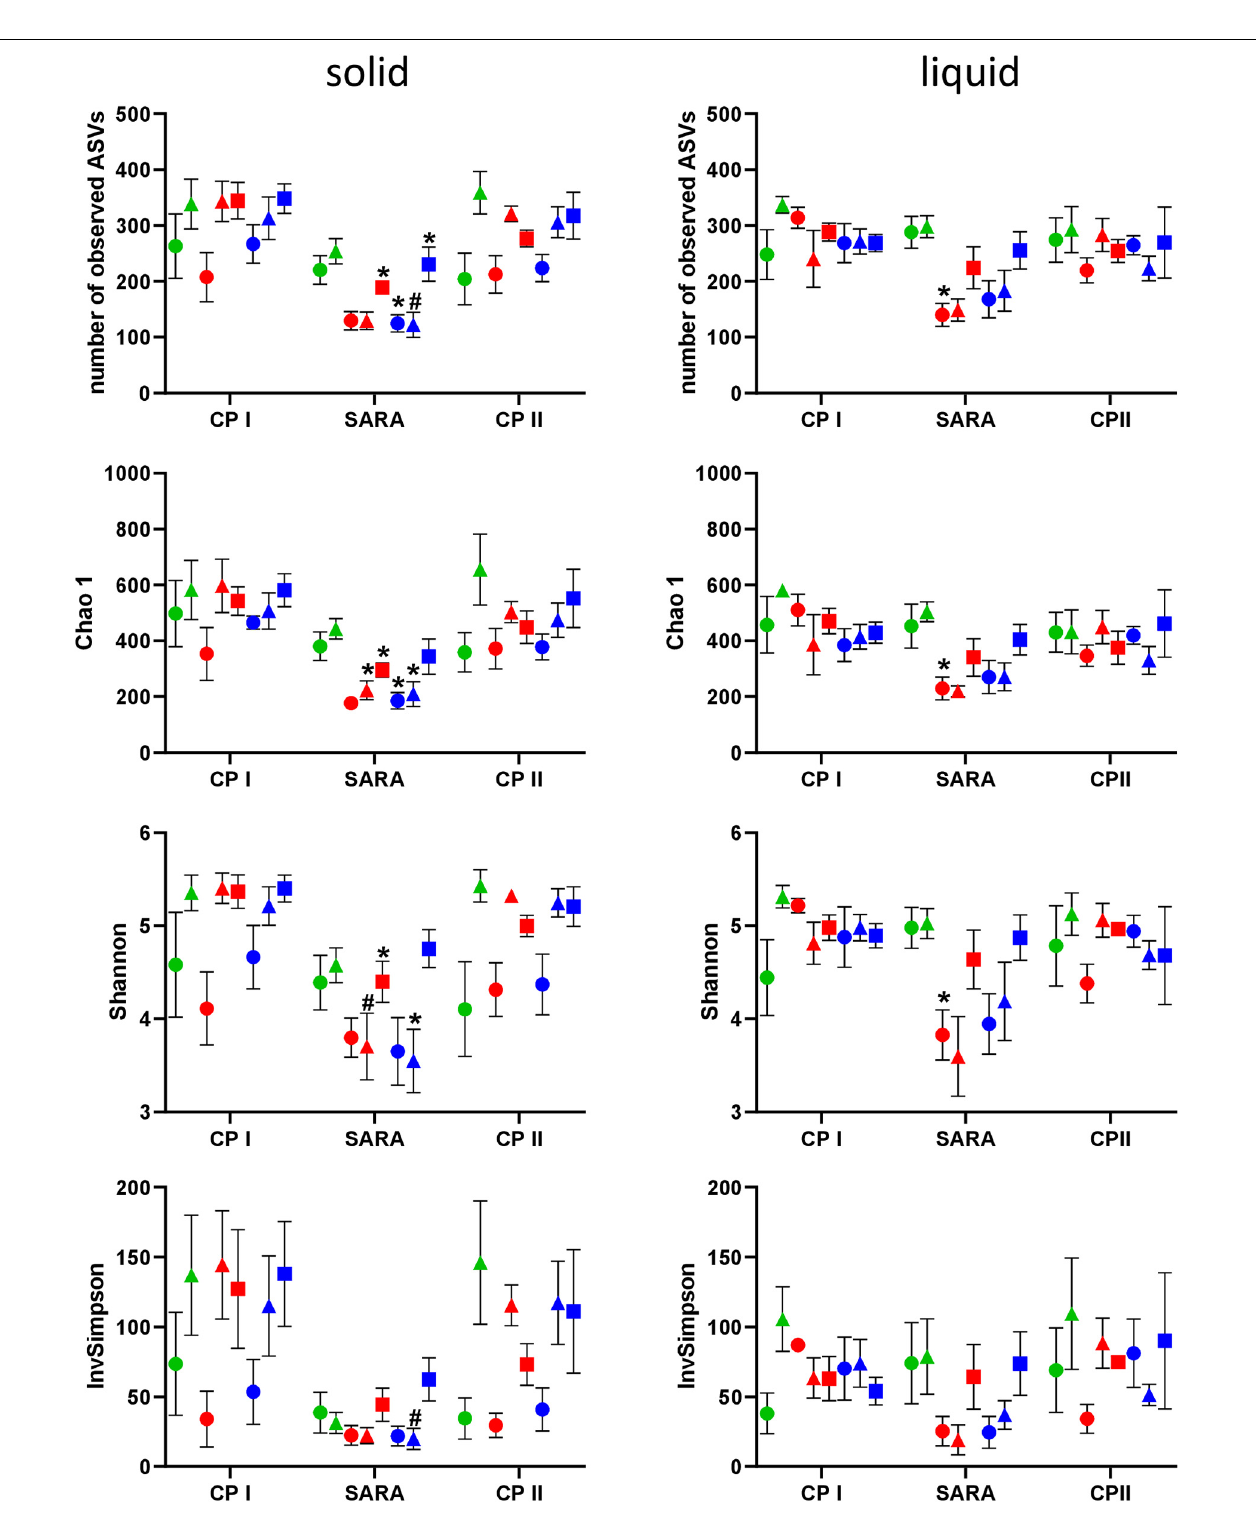
FIGURE 2 | Alpha diversity of the RUSITEC samples analyzed by PacBio sequencing. Samples were collected during control period I (CP I), subacute rumen acidosis period (SARA), and control period II (CP II). Samples from the solid (left) and liquid (right) phase of the fermenters were collected. Alpha diversity measures were calculated. The treatment groups are marked according to the buffer type by colors (green = standard buffer, red = SARA I buffer, blue = SARA II buffer) and according to the concentrate ratio by shape (dots = 70% concentrate, triangles = changing ratio, squares = 30% concentrate). Asterisks indicate groups that differ significantly between CP I and SARA. Hashes indicate with significant differences between SARA and CP II. Data are presented as means ± SEM.